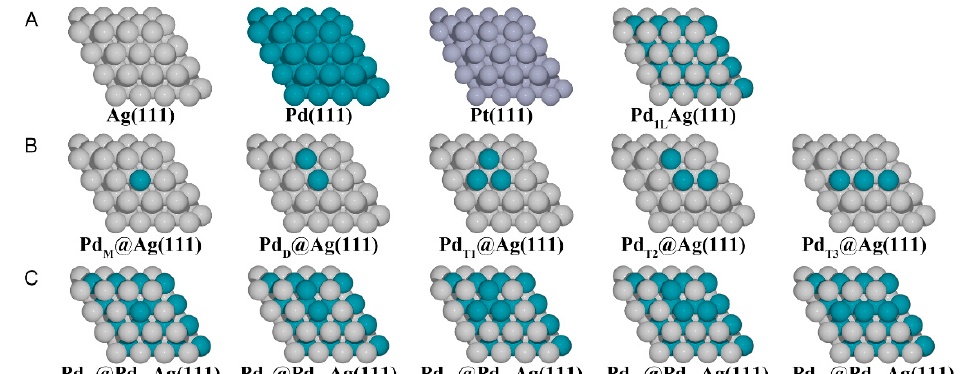
Figure 1. Considered geometries in this work. ( A ) The pure metal surfaces, Ag(111), Pd(111), and Pt(111), ( B ) modified PdAg(111) surfaces on the first layer, ( C ) modified PdAg(111) surfaces with a Pd subsurface layer. Pd monomer (indicated as M), dimer (D), and trimer (T). The silver, cyan, and gray balls represent Ag, Pd, and Pt atoms, respectively.